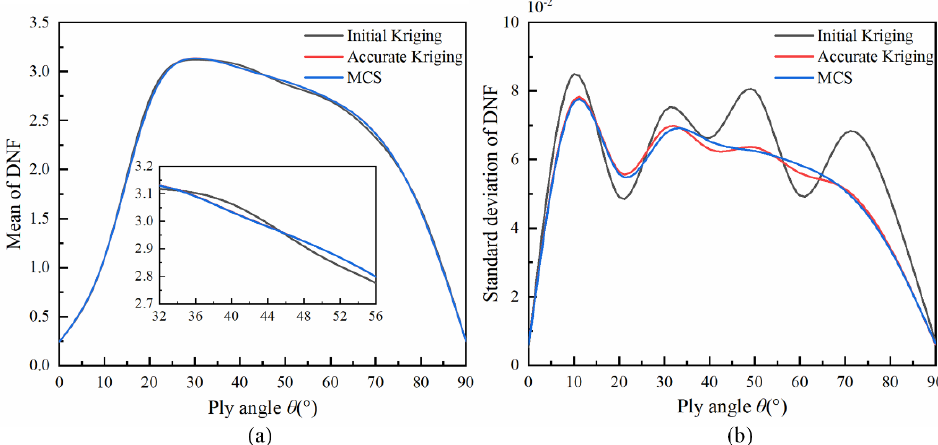
Figure 4. The mean and standard deviation of DNF for the three-layer laminated composite cylindrical shells with supported–supported boundary conditions. ( a ) mean, ( b ) standard deviation.